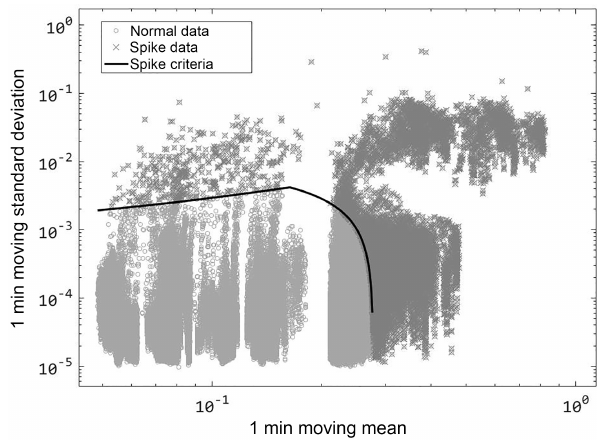
Figure 3. Phase space diagram showing moving window statistics of IRGA signal (17 days of 20Hz data).